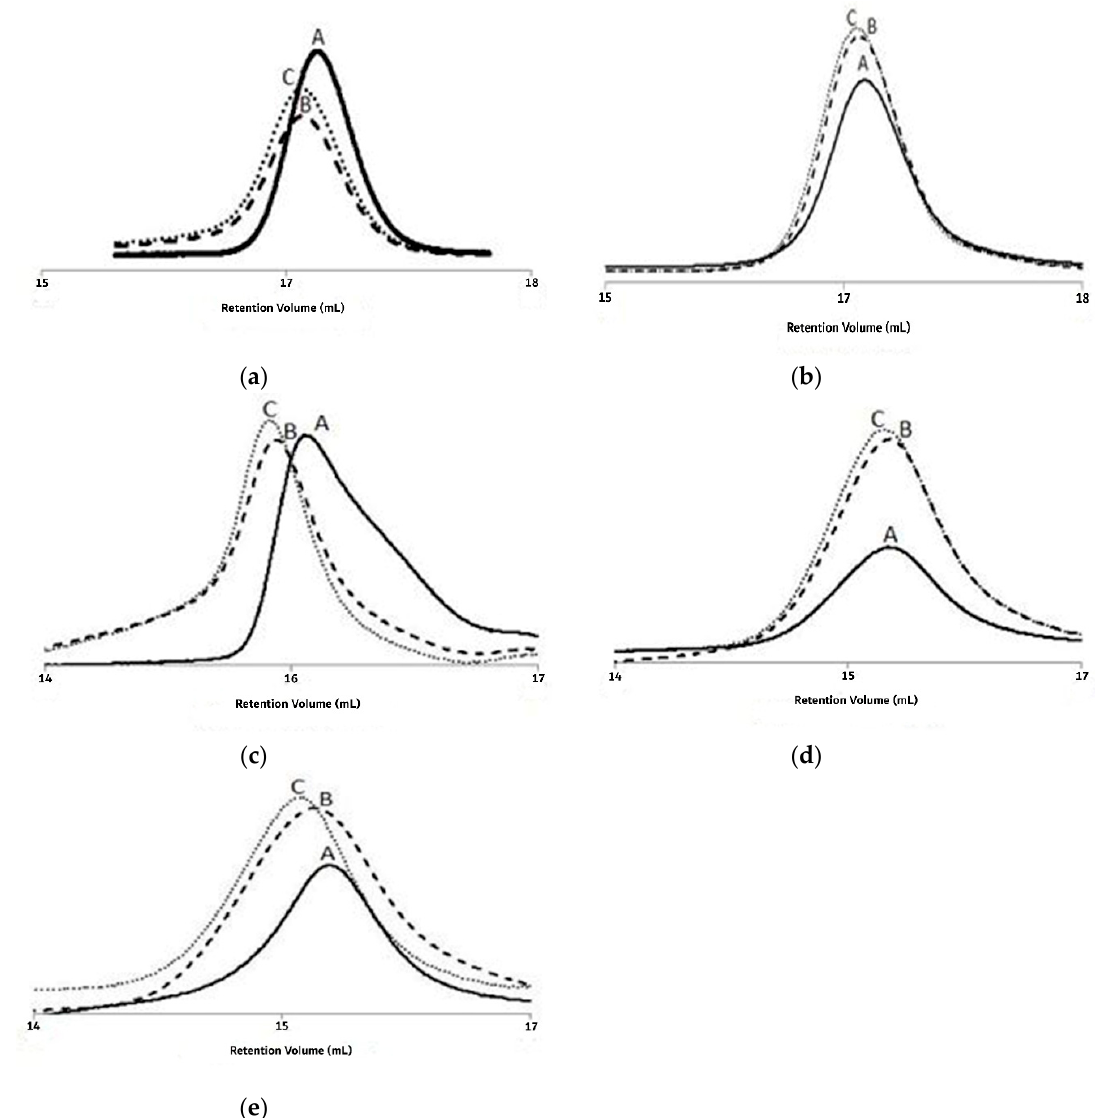
Figure 5. For experiments E2, E4, E6, E9, and E12: gel permeability chromatography (GPC) traces ( A – C ) of the poly(methyl methacrylate) (PMMA) molecular weight distribution (MWD) at 1, 3, and 5 h of reaction time. ( a ) The GPC peaks shift of PMMA for 12.1, 24.9 and 34.1% conversions, respectively in trial E2; ( b ) The GPC peaks shift of PMMA for 37.7, 52.6 and 64.1% conversions, respectively in trial E4; ( c ) The GPC peaks shift of PMMA for 19.7, 34.7 and 42.3% conversions, respectively in trial E6; ( d ) The GPC peaks shift of PMMA for 35.9, 50.7 and 60.0% conversions, respectively in trial E9; ( e ) The GPC peaks shift of PMMA for 28.2, 42.6 and 59.3% conversions, respectively in trial E12.